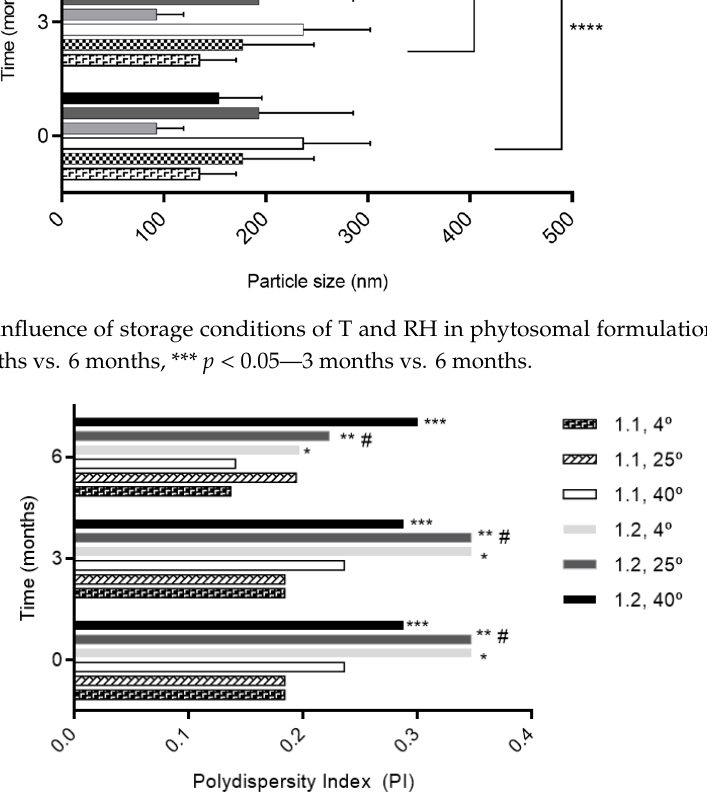
Figure 2. The influence of storage conditions of T and RH in PI of phytosomal formulation. * p < 0.05 vs. 1:1, 4 ◦ C; ** p < 0.05 vs. 1:1, 4 ◦ C; *** p < 0.05 vs. 1:1, 4 ◦ C; # p < 0.05 vs. 1:1, 25 ◦ C.